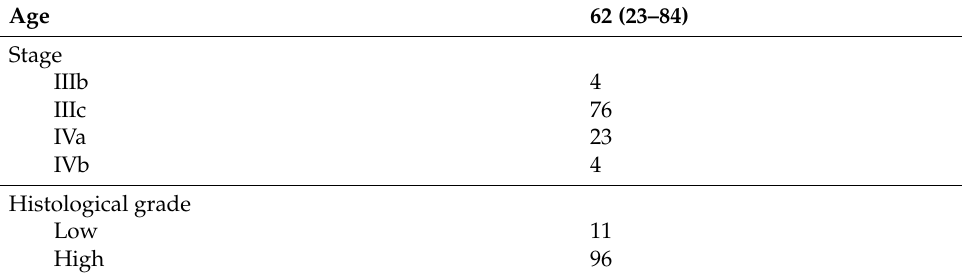
Table 1. Patient characteristics at enrolment and